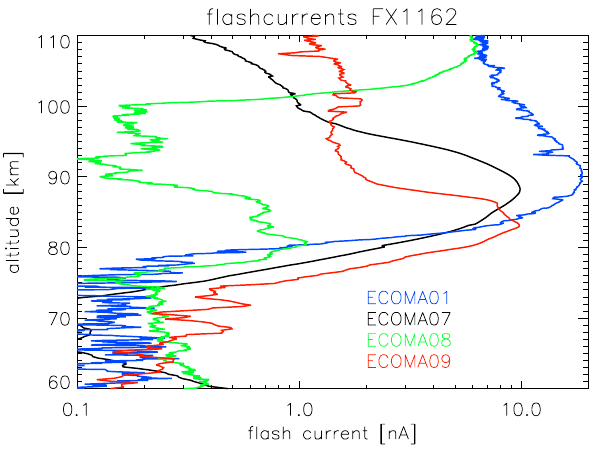
Fig. 7. Overview of photoelectron currents obtained during all ECOMA flights outside the polar summer, i.e., ECOMA01, ECOMA07, ECOMA08 and ECOMA09 obtained with the flash- lamps with the largest photon energy, i.e., type FX1162 (i.e., λ >